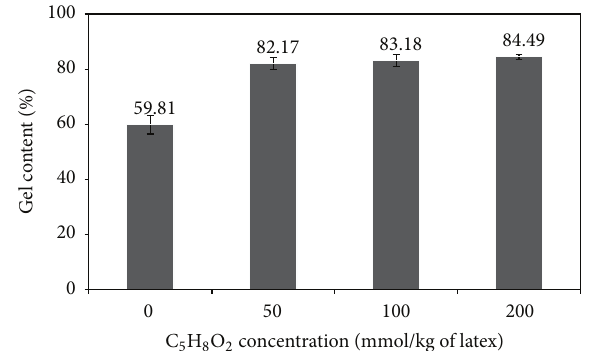
Figure 6: Plasticity retention index (PRI) of NR obtained from the fresh NR latex treated with different concentrations of C 5 H 8 O 2 .